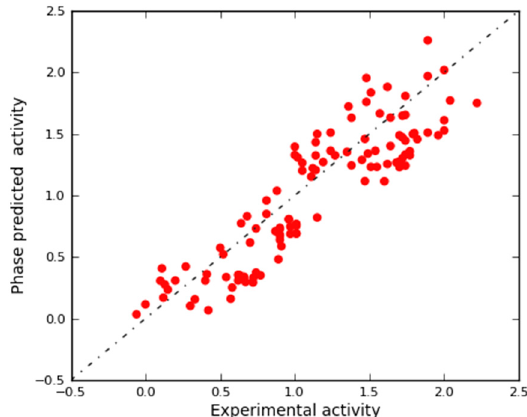
Figure 6. Scatter plot for the predicted (Phase-predicted activity) and observed (experimental activity) pIC 50 values (µM) as calculated by the 3D-QSAR model with 7 factors applied to the external test set.